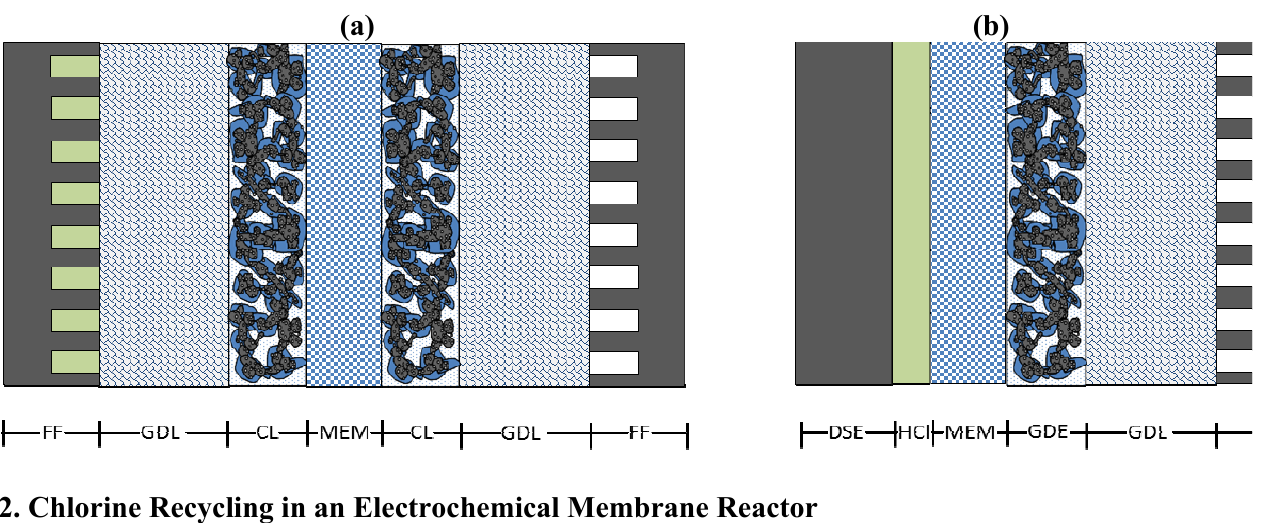
Figure 1. Schematic presentations of different reactor types used for HCl electrolysis: ( a ) dimensionally stable electrodes–gas diffusion electrodes (DSE–GDE) and ( b ) gas diffusion electrodes–gas diffusion electrodes (GDE–GDE)